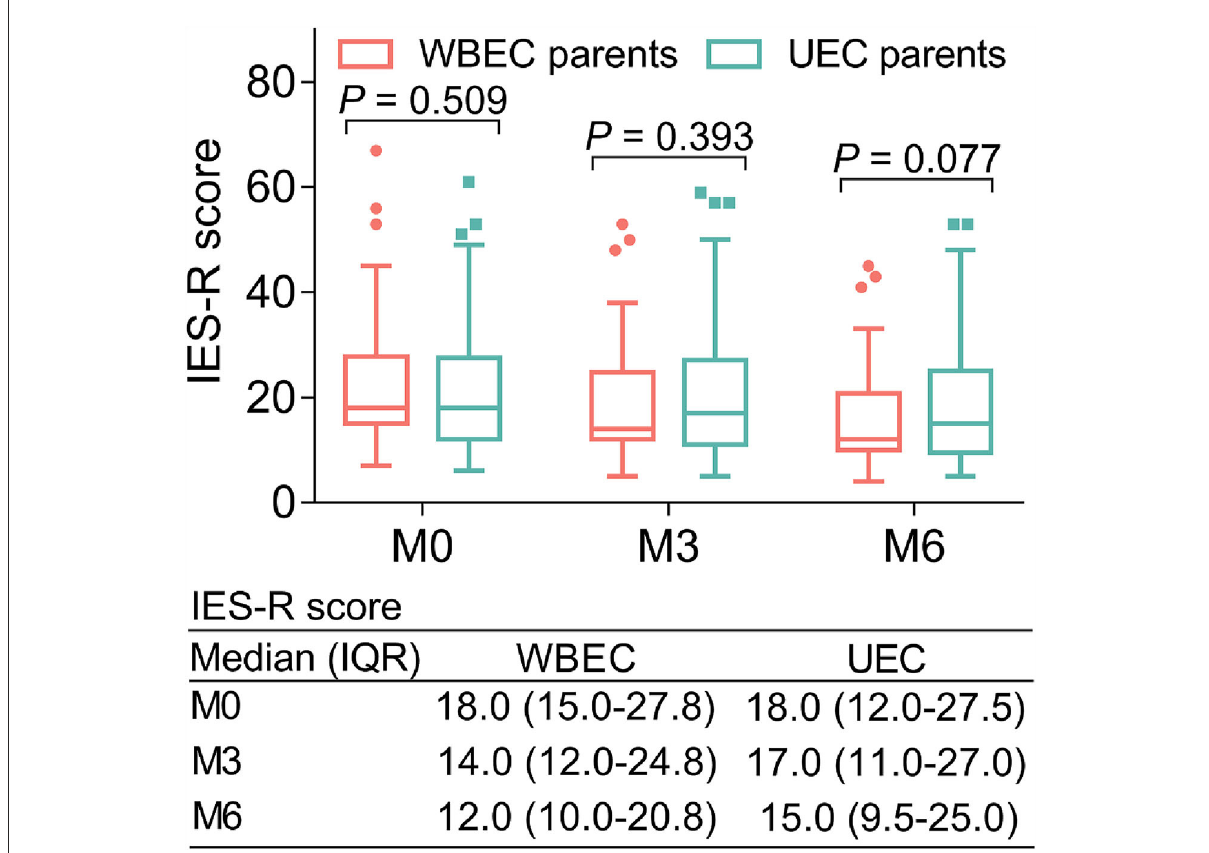
FIGURE4 Effect of WBEC on PTSD in parents of pediatric and adolescent patients with osteosarcoma. Comparison of IES-R score at M0, M3, and M6 between parents in WBEC group and UEC group. WBEC, WeChat-platform-based education and care program; UEC, usual education and care program; IES-R, Impact of Event